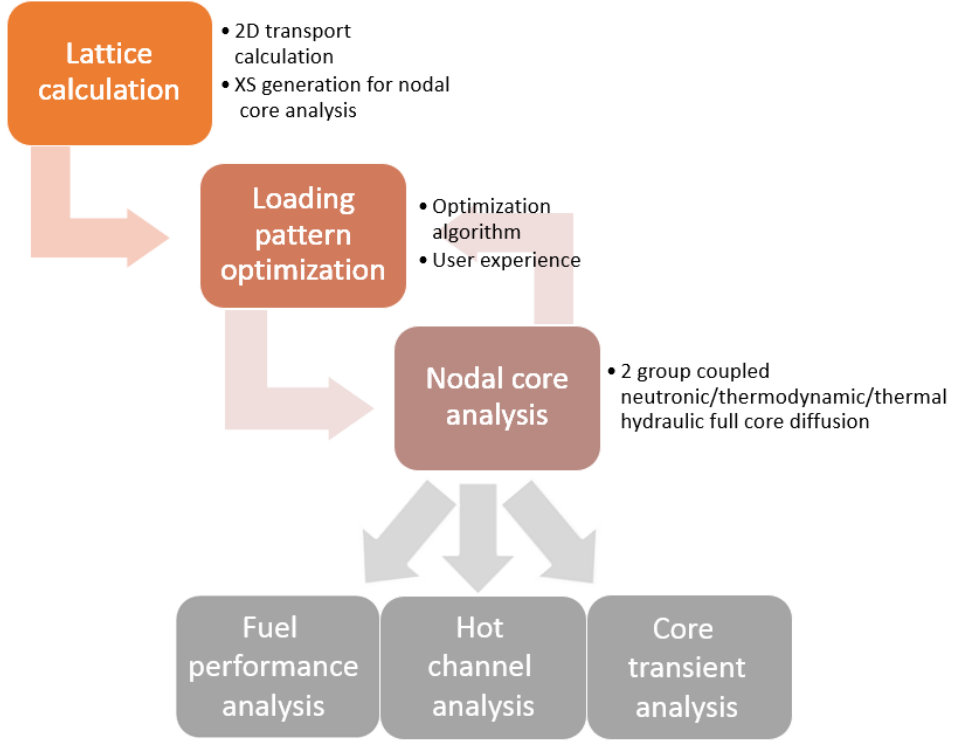
Figure 1. The current calculation route for the fuel management in a light water reactor.